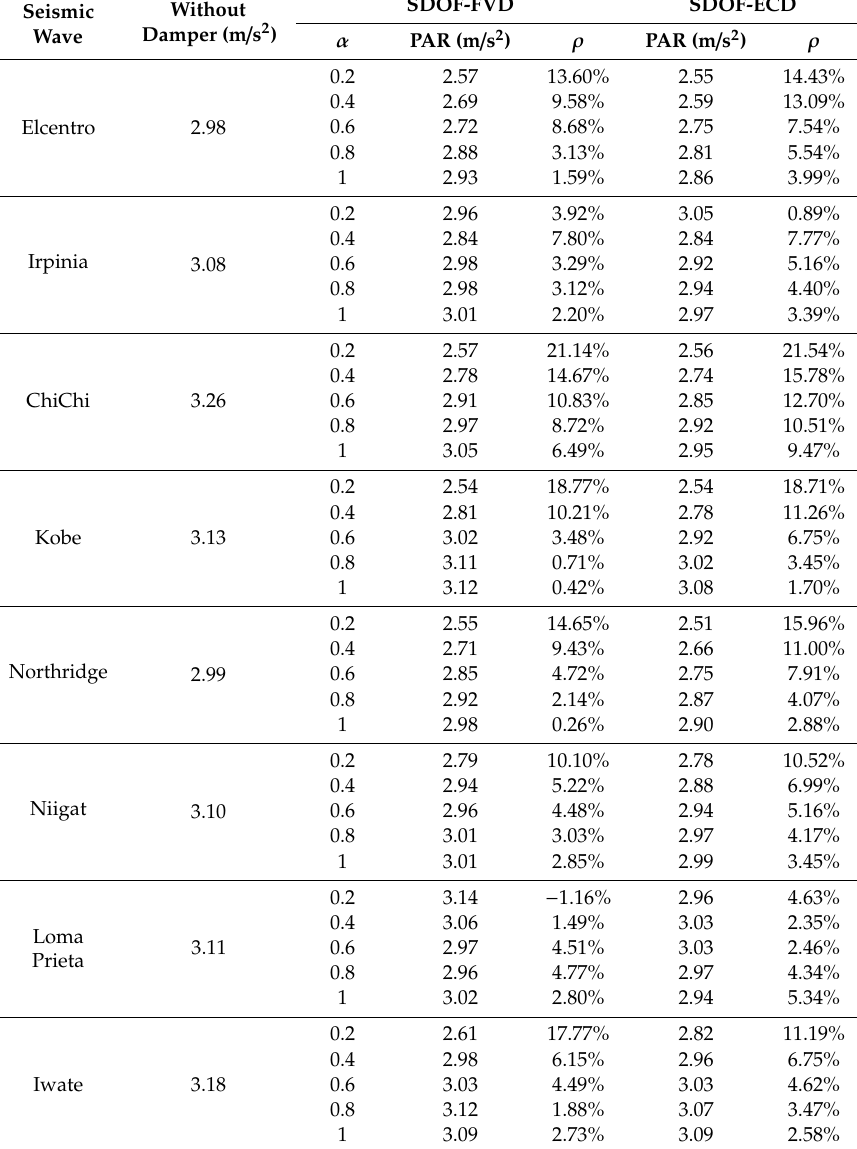
Table 2. Peak acceleration responses (PARs) of SDOF-ECDs and